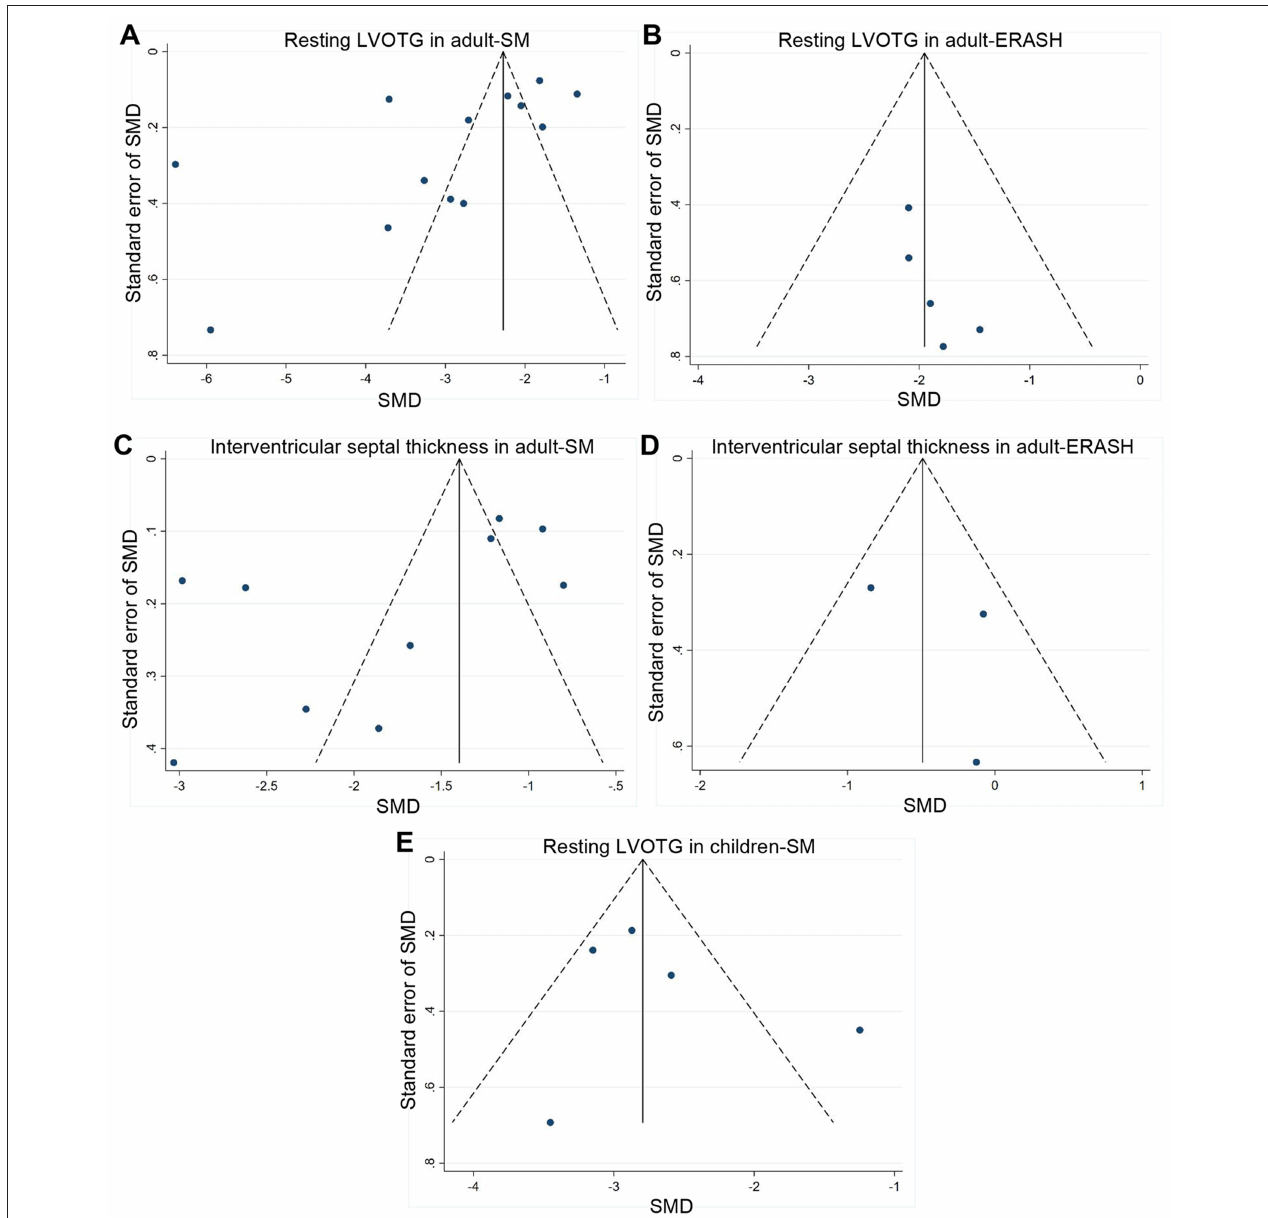
FIGURE 4 | Funnel plots for publication bias. (A,B) Funnel plots for the resting LVOTG in adult-SM groups (A) and adult-ERASH groups (B) . (C,D) Funnel plots for the interventricular septal thickness in adult-SM groups (C) and adult-ERASH groups (D) . (E) Funnel plot for the resting LVOTG in children-SM groups. ERASH, endocardial radiofrequency ablation of septal hypertrophy; LVOTG, left ventricular outflow tract gradient; SM, septal myectomy; SMD, standardized mean